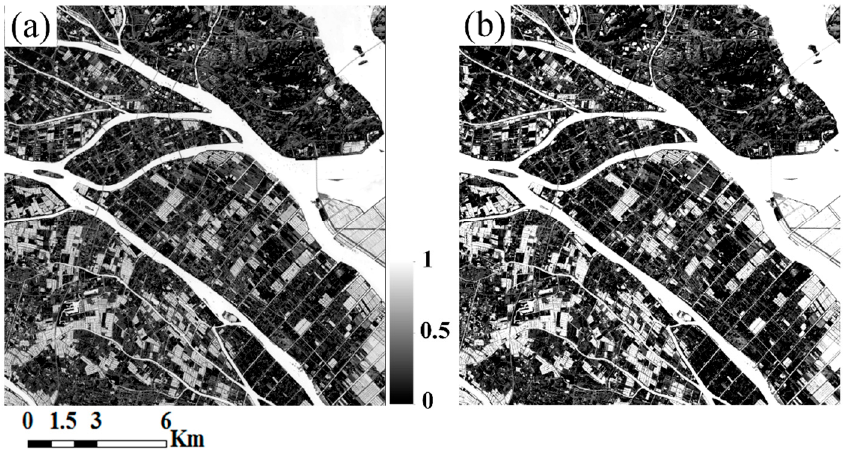
Figure 12. Surface water fractions of Region E extracted by the: ( a ) conventional; and ( b ) modified